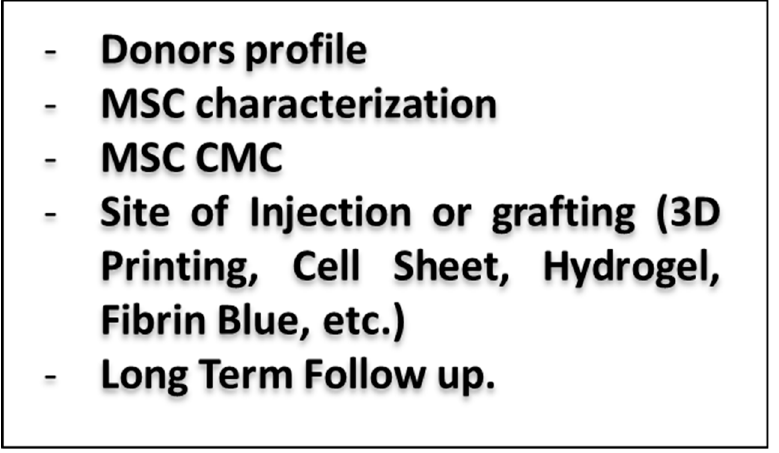
Figure 1. Effect of Mesenchymal Stem Cells (MSCs) on organs Ischemia-Reperfusion Injury (IRI). Lines with line head show the inhibitory effect of the MSC on factors damaging the organs. Arrows show activation of protective pathway.